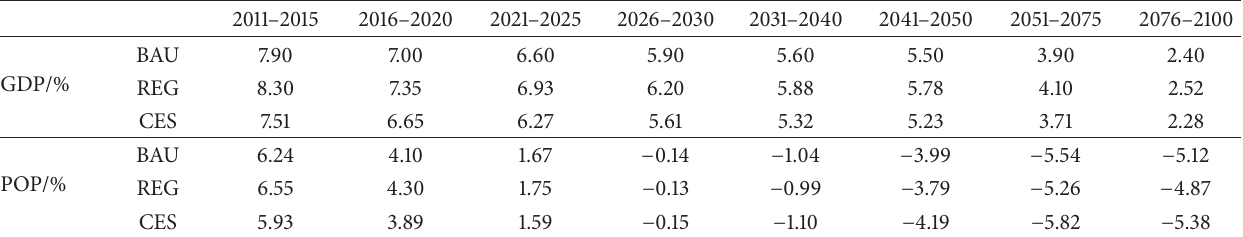
Table 1: Projected change rates of GDP and population (POP) in China,